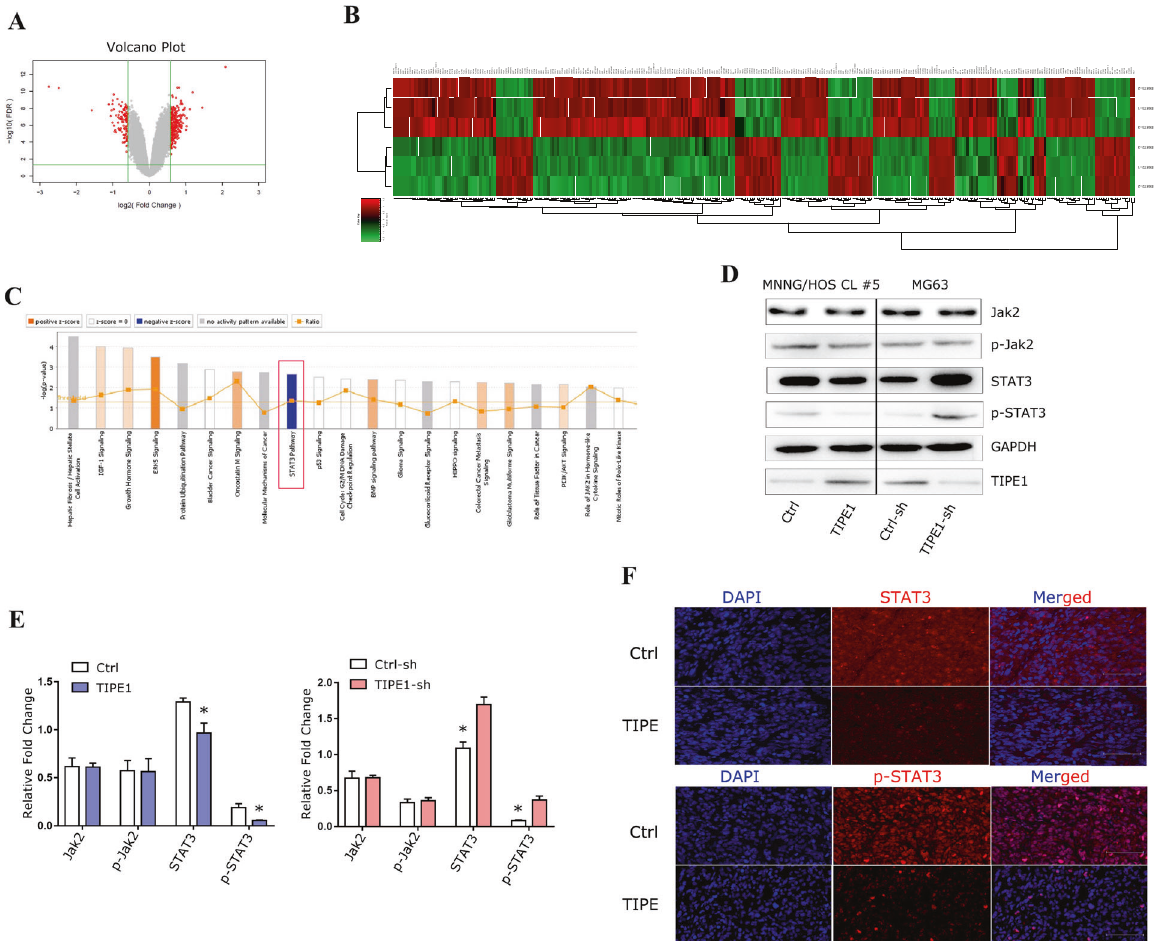
Fig. 4 TIPE1 speci fi cally inhibits STAT3 expression. Volcano plot A , Heatmap B and Ingenuity Pathway Analysis C showed that TIPE1 overexpression inhibited the STAT3 signaling pathway. D , E Western blotting assay showed that overexpression of TIPE1 speci fi cally decreased total STAT3 and p-STAT3 levels in MNNG/HOS Cl #5 cells, while knockdown of TIPE1 expression increased total STAT3 and p-STAT3 expression in MG63 cells. F Immuno fl uorescence analysis suggested that overexpression of TIPE1 reduced the expression of total STAT3 and p-STAT3 in MNNG/HOS Cl #5 cells. The data represent the means ± SDs of 3